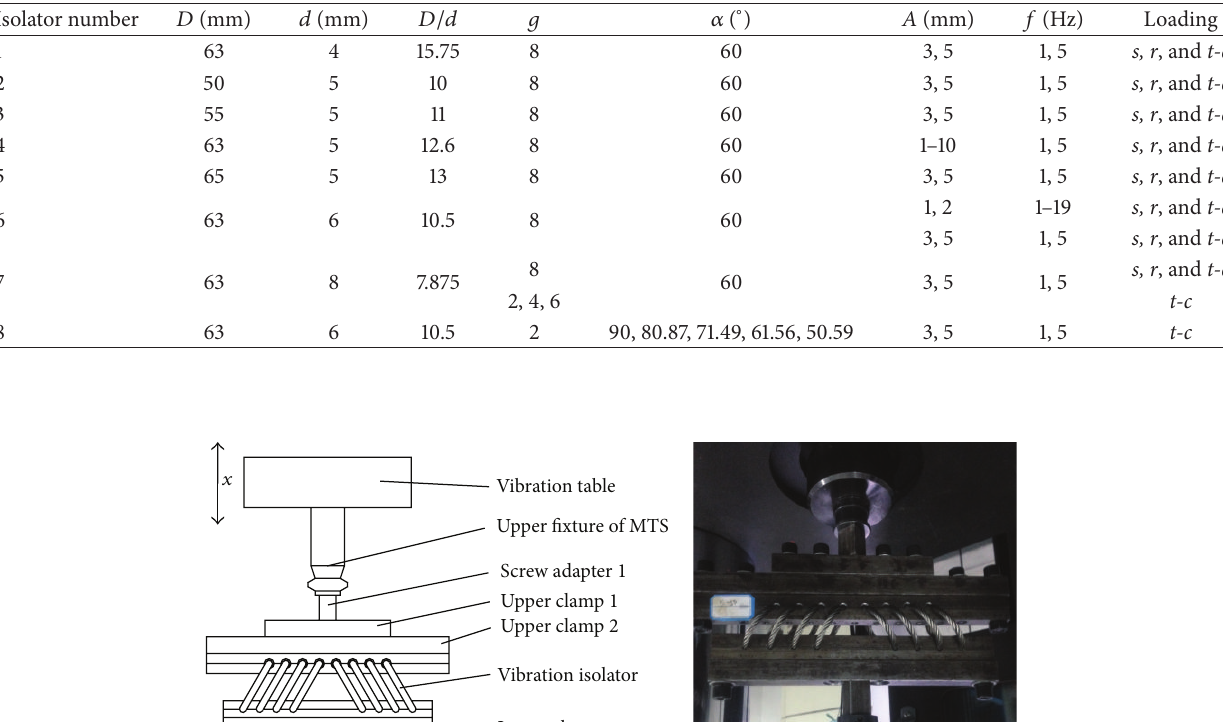
Table 1: Experiment scheme.